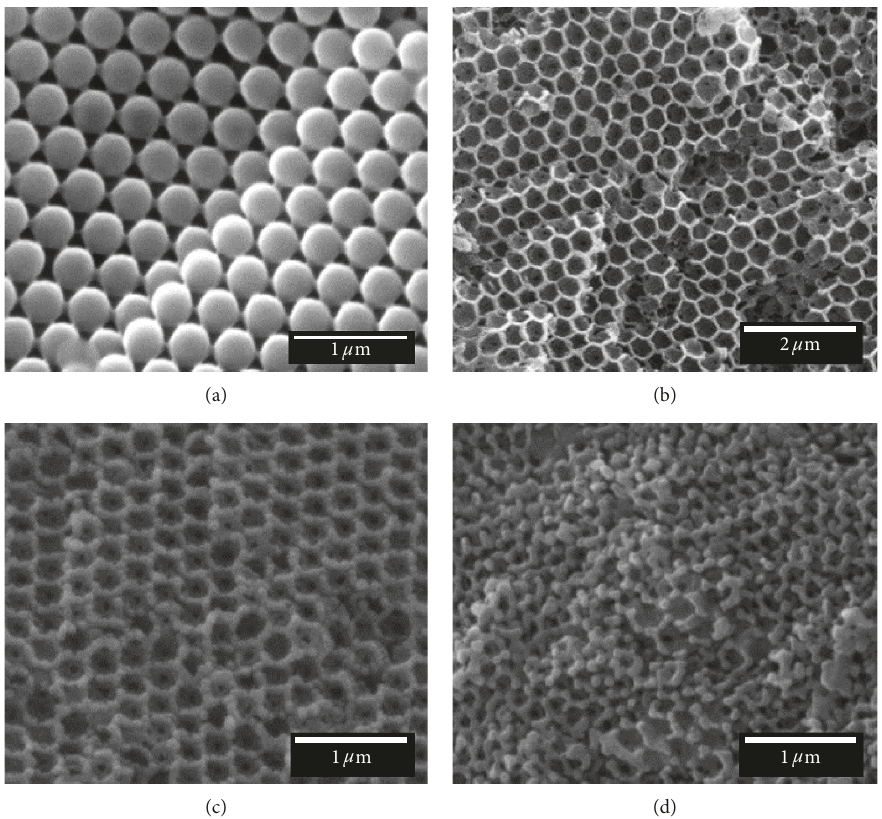
Figure 1: SEM images of (a) PMMA colloid crystals and (b–d) 3DOM CaO/SiO